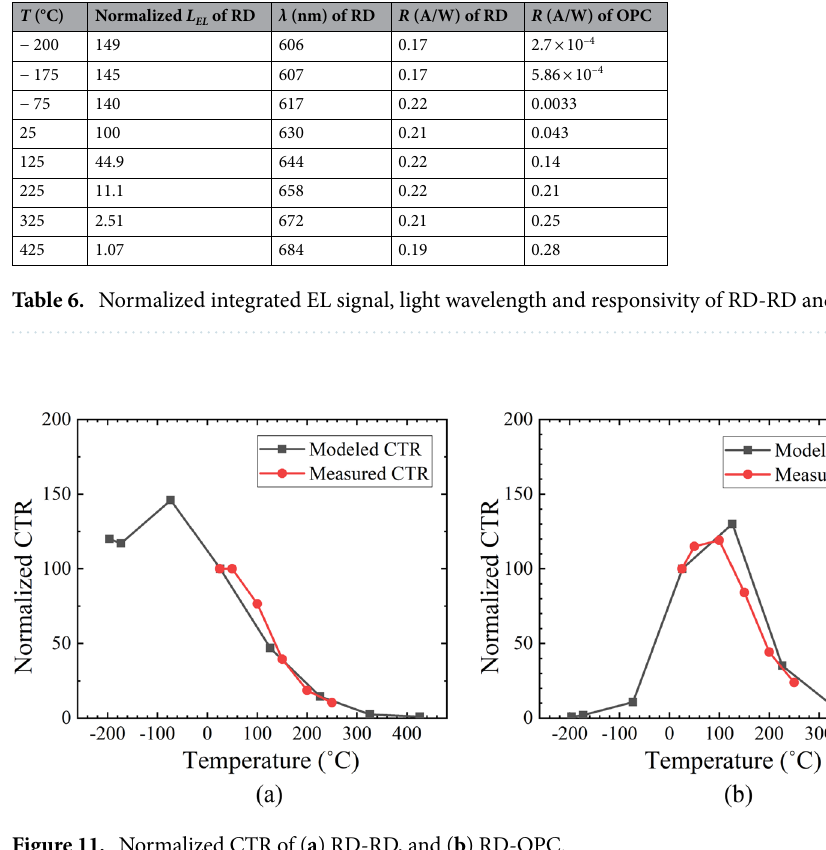
Figure 11. Normalized CTR of ( a ) RD-RD, and ( b )